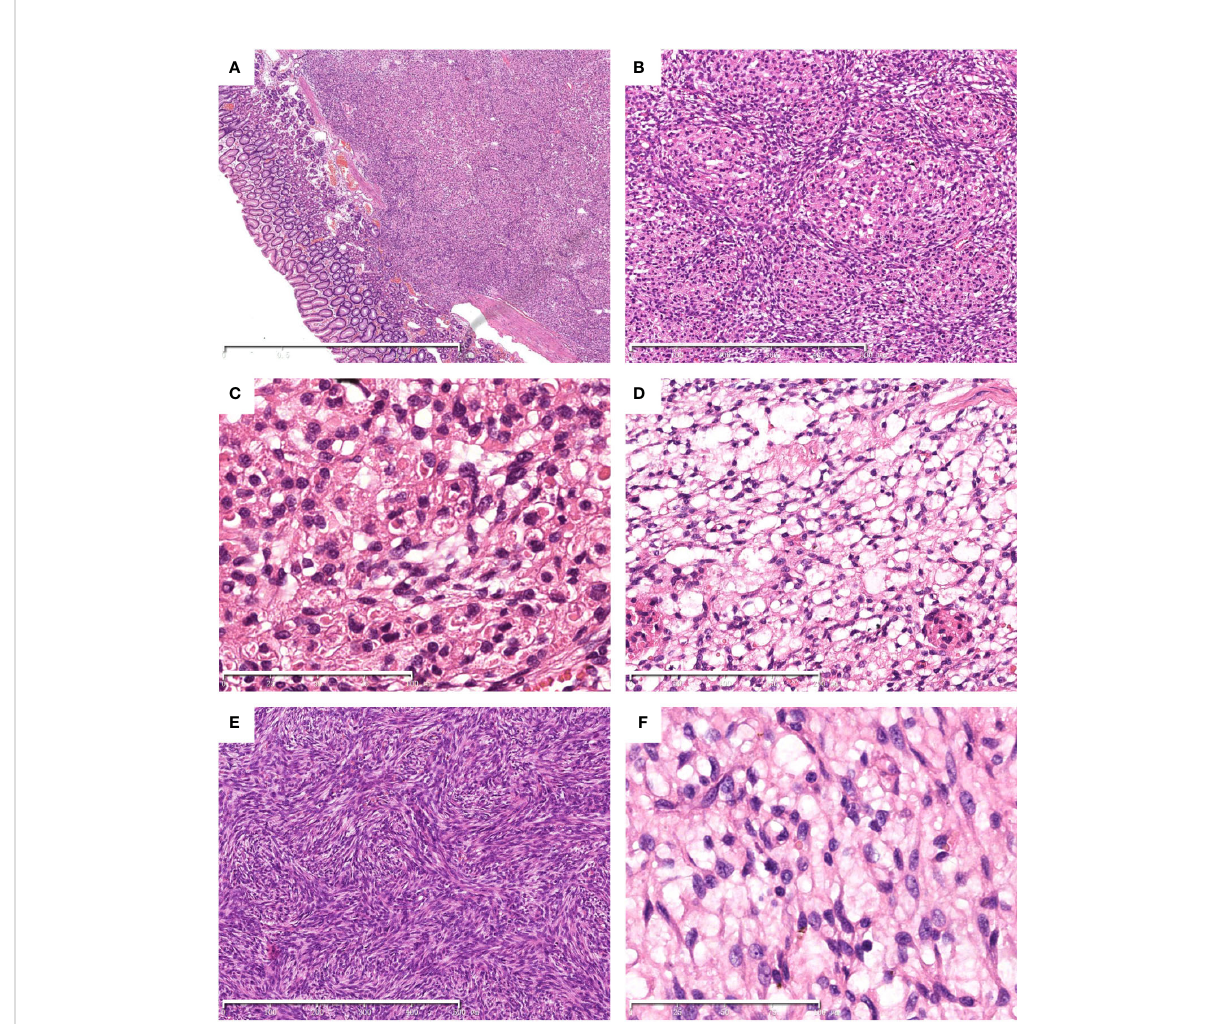
FIGURE 1 Histological fi ndings of the tumor. Hematoxylin and eosin (HE) stain. The tumor centered in the submucosa with focal invasion to the mucosa. (A) A biphasic histology with epithelial and spindle cells was noted (B) . Cytoplasmic eosinophilic granules and globules were observed in the bland-looking epithelial cell component (C) . The spindle cells arranged in reticular (D) and storiform (E) pattern. The spindle cell component shows a bland appearance (F) . The scale bars (2mm in A , 500 m m in B and E , 200 m m in D , 100 m m in C and F